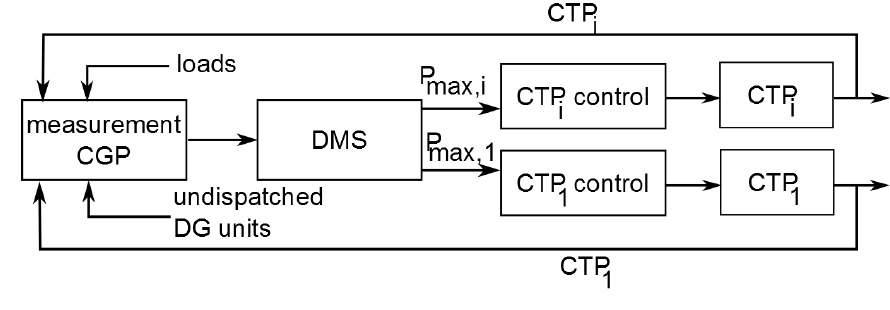
Figure 2. Control strategy: overview.